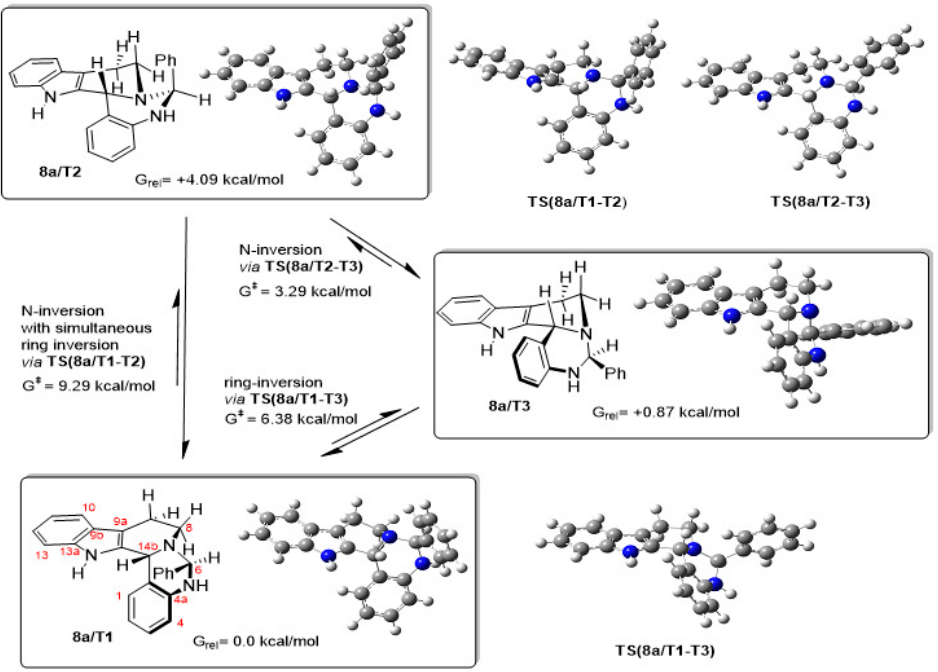
Scheme 2. Schematic representations and optimized structures of the possible diastereomers of pentacycle 8a / T1 characterised by relative free energy values and barriers of their interconversion proceeding via the presented TS structures as disclosed by a series of DFT modelling studies.